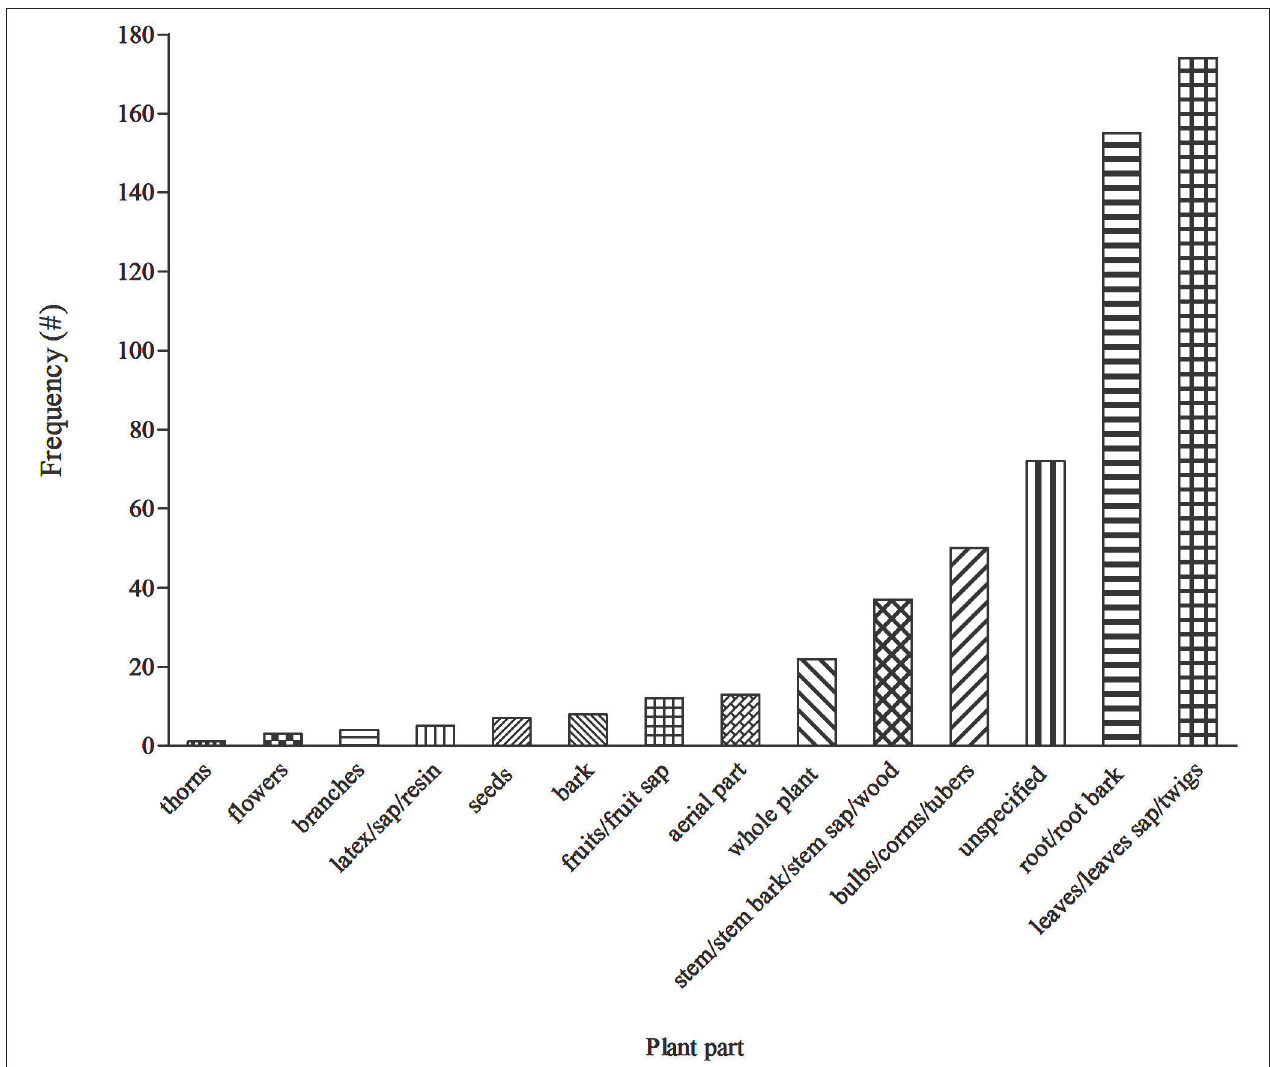
FIGURE 3 | Distribution of medicinal plant parts used to treat cattle diseases in South